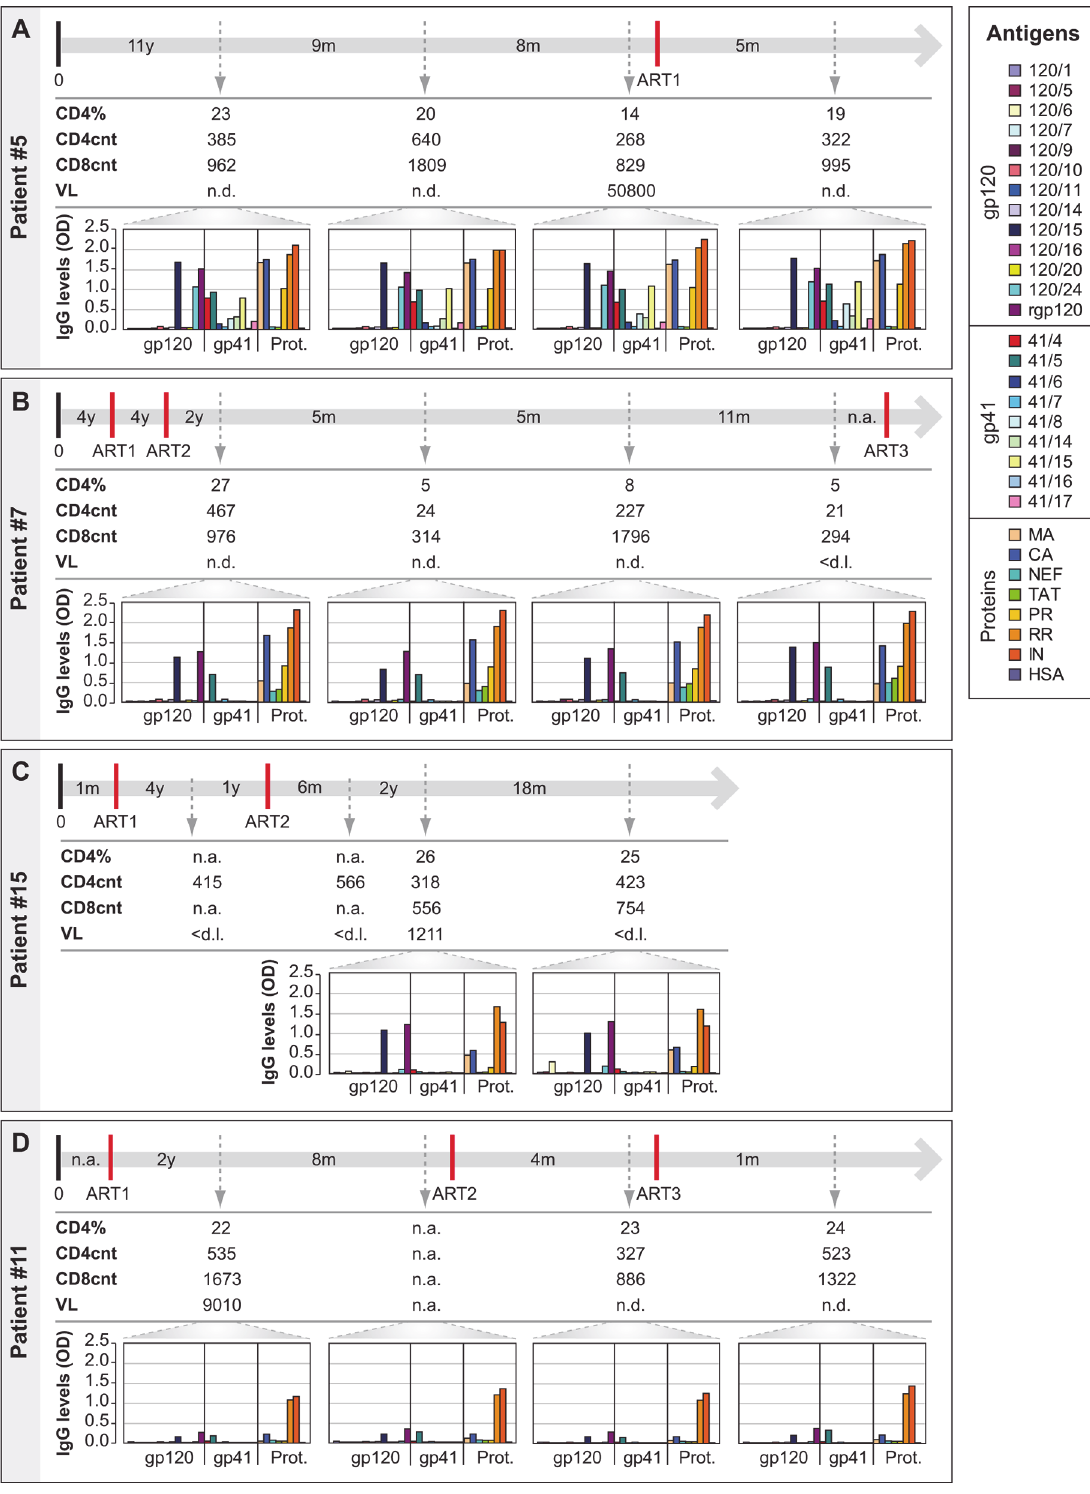
Fig 4. Monitoring of CD4+ and CD8+ T-cell counts, viral loads and IgG reactivity profiles to HIV-1 clade C-derived proteins and peptides during infection and treatment. Displayed are percentages of CD4+ T-cells, CD4+ and CD8+ T-cell counts, viral loads and levels of IgG antibodies to HIV-1 clade C-derived proteins and peptides (the box shows color codes of antigens and peptides) over time (top line) for patients with constant antibody reactivity profiles (A: patient #5; B: patient #7; C: patient #15; D: patient #11). Abbreviations: 0, 1 st positive test / 1 st visit; ART, antiretroviral therapy; ART1, ART2